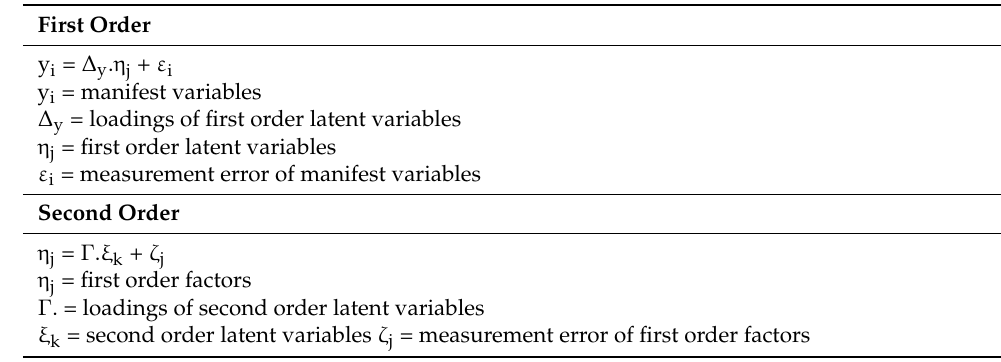
Table 2. Estimation of transactional vs. relational psychological contracts as a reflective hierarchical